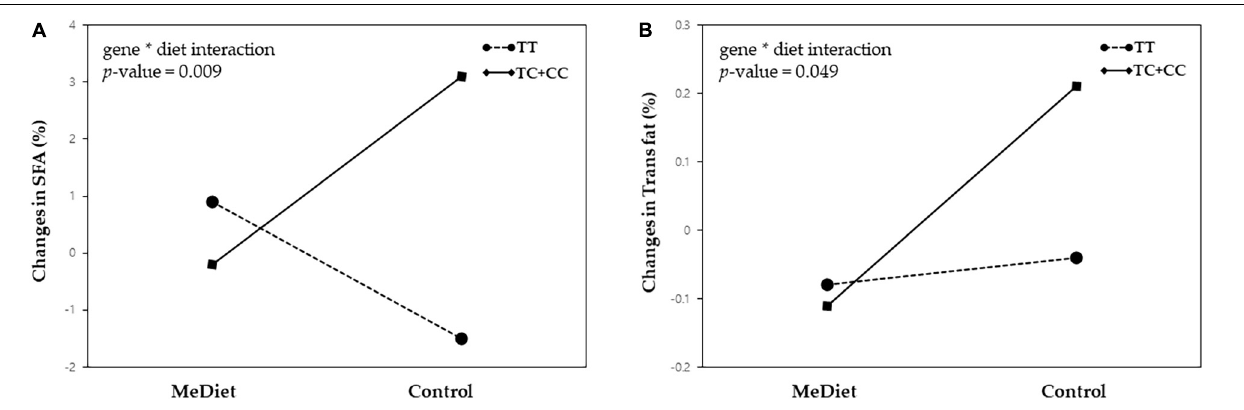
was found between MC4R rs476828 and dietary intervention